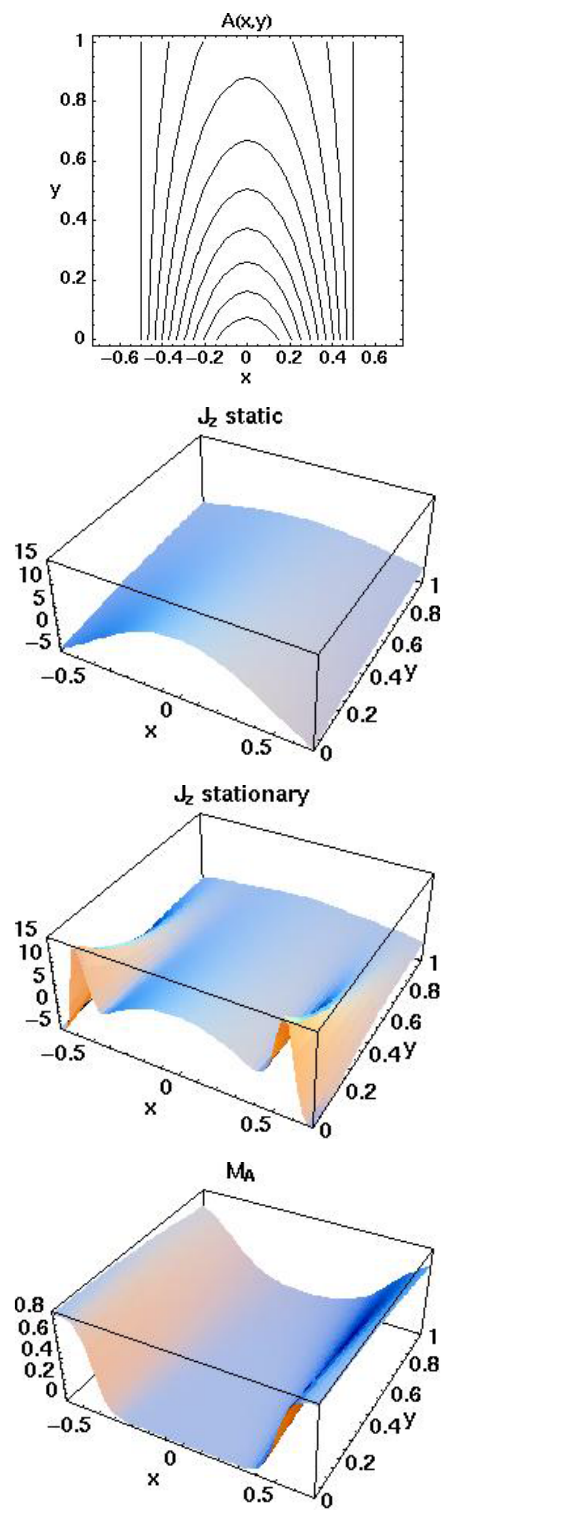
Fig. 4. Same transformation as in Fig. 2, but including a linear MHS current in the form J z (A) = c · A with c = 1 . 2. Here c >k